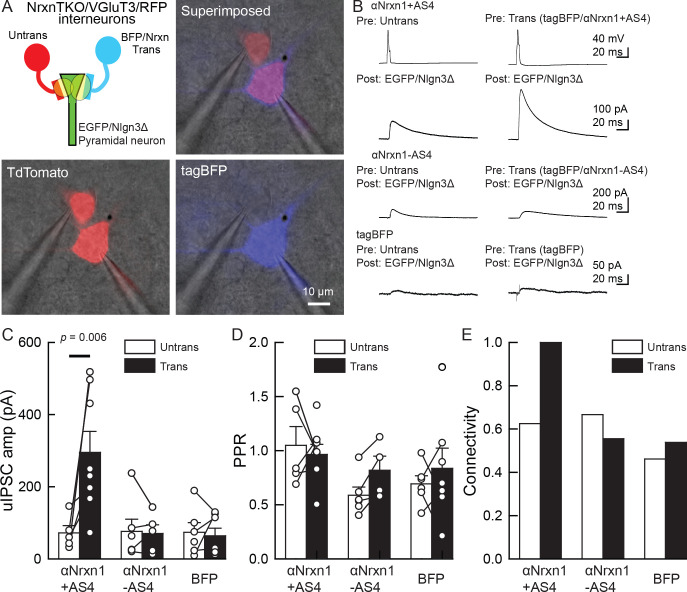
An αNrxn1+AS4–Nlgn3Δ synaptic signal enhances VGT3+ inhibitory synapse transmission.(A–C) Effect of pre- and postsynaptic overexpression of αNrxn1 and Nlgn3Δ, respectively, on unitary inhibitory synaptic transmission in organotypic slice cultures prepared from VGT3/NrxnTKO/RFP mice. (A) Configuration of triple whole-cell recording (left top), superimposed fluorescent, and Nomarski images (right top). (Bottom) Individual fluorescence and Nomarski images of TdTomato (left) and tag-blue fluorescent protein (tag-BFP; right). (B) Averaged sample unitary inhibitory postsynaptic current (uIPSC) traces. Nrxns and Nlgn3Δ were transfected in TdTomato-positive and CA1 pyramidal neurons, respectively, by electroporation. (C, D, and E) Summary of uIPSC amplitude (C), paired-pulse ratio (D), and connectivity (E). Numbers of cell pairs: αNrxn1+AS4, αNrxn1-AS4, and BFP at VGT3+ synapses (seven pairs/three mice, 9/4 and 9/4). The number of tested slice cultures is the same as that of cell pairs. Mann–Whitney U-test.